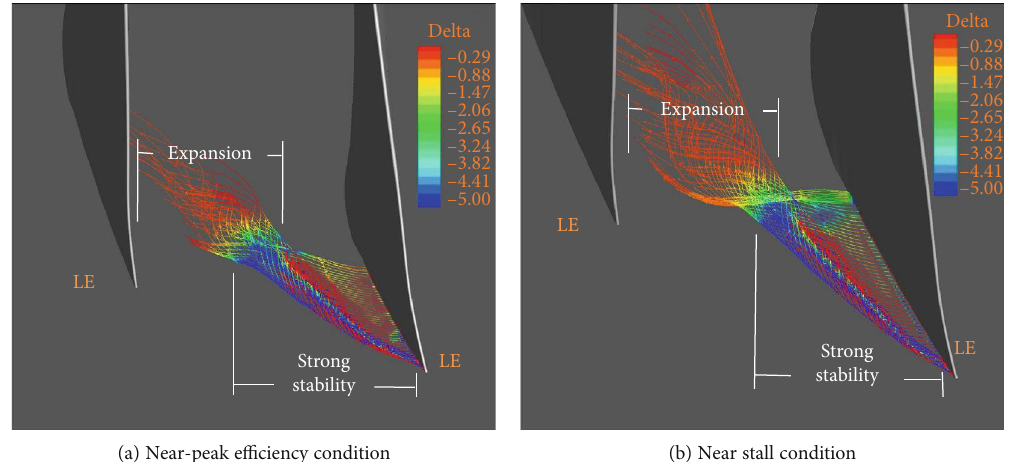
Figure 28: Judgment of shock-induced vortex stability by parameter Delta at both near-peak e ffi ciency and near stall